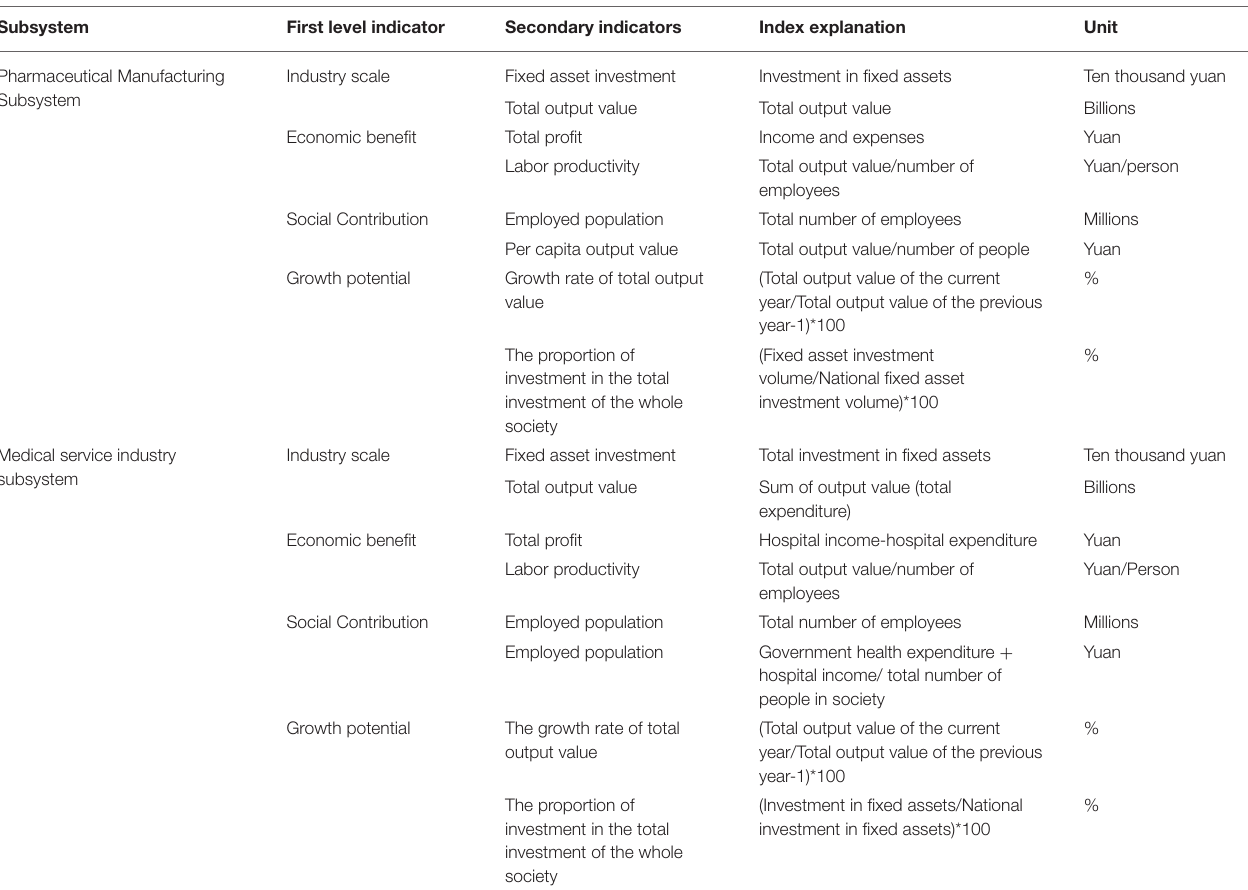
TABLE 1 | Index system to measure the coupling and coordination degree in the development of the pharmaceutical manufacturing industry and the medical service industry.